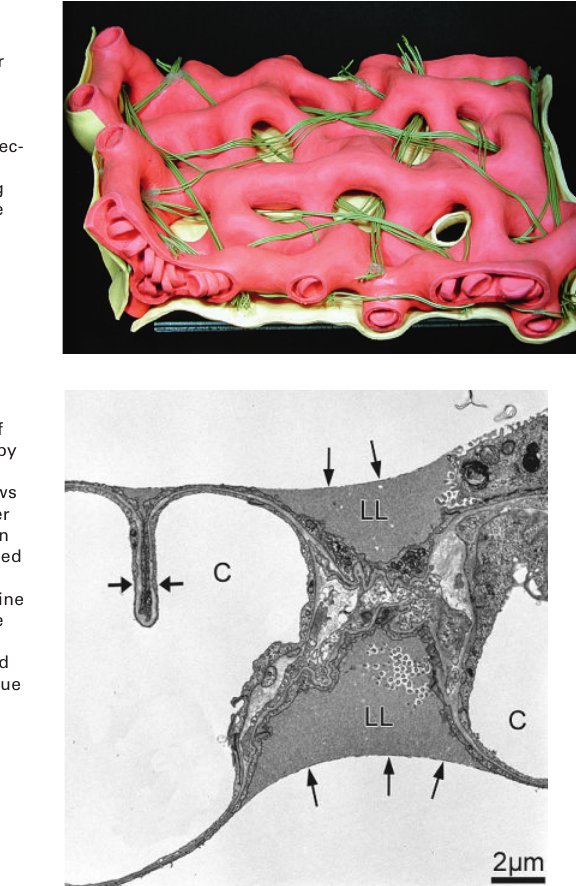
Model of capillary network in alveolar septum (compare with fig. 2) inter- woven with the meshwork of connec- tive tissue fibres (green) with strong fibre bundle in free edge of septum at right.